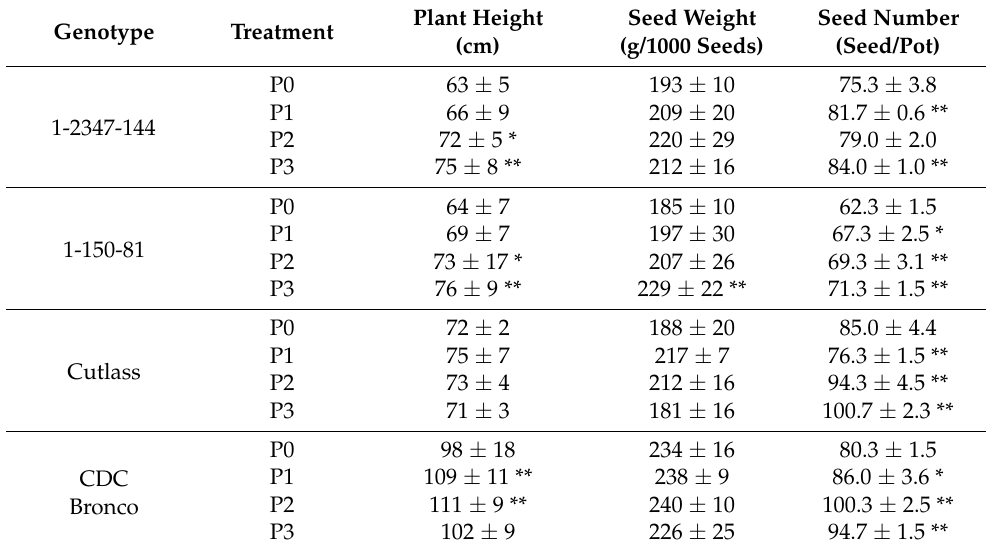
Table 2. The effect of the foliar phosphorus application on the plant height, seed weight and number of